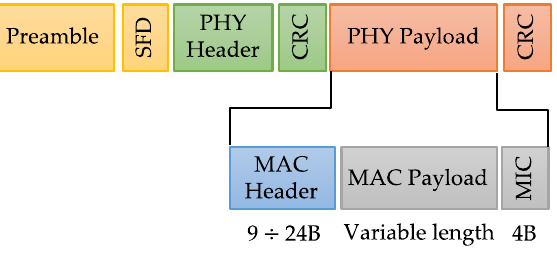
Figure 9. Schematic diagram of the LoRaWAN message fields. SFD: Start of Frame Delimiter, PHY: Physical Layer, CRC: Cyclic Redundancy Check, MAC: Medium Access Control, MIC: Message Integrity Code.